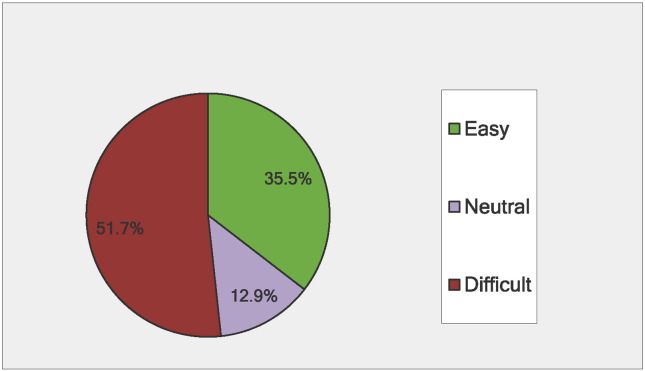
Percentage of respondents reporting that managing PKU treatment was: Easy1, Neutral, or Difficult2 (N = 615).1: Combines Likert scale responses for: ‘very easy’, ‘easy’, and ‘somewhat easy’2: Combines Likert scale responses for: ‘somewhat difficult’, ‘difficult’, and ‘very difficult’.